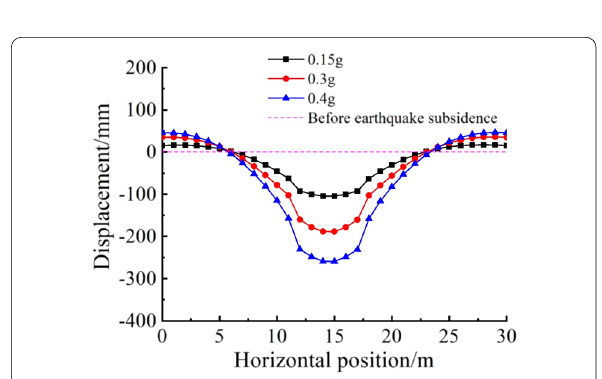
Fig. 14 Uneven seismic subsidence of ground surface due to El Centro ground motion with different PGA